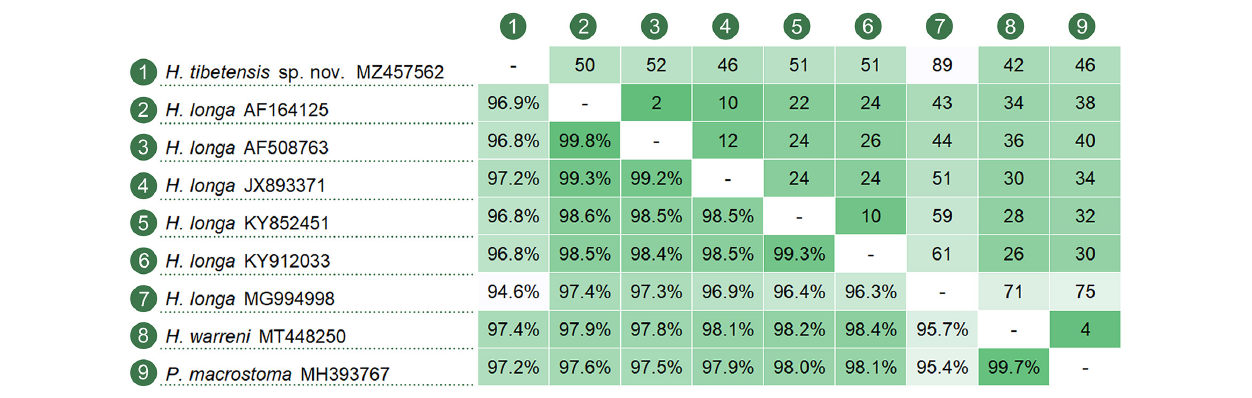
FIGURE 6 | Nucleotide comparison among populations of Hemiurosomoida species and Parakahliella macrostoma , based on SSU rRNA gene sequences. A matrix showing the percentage of sequence identity (below the diagonal) and the number of unmatched nucleotides (above the